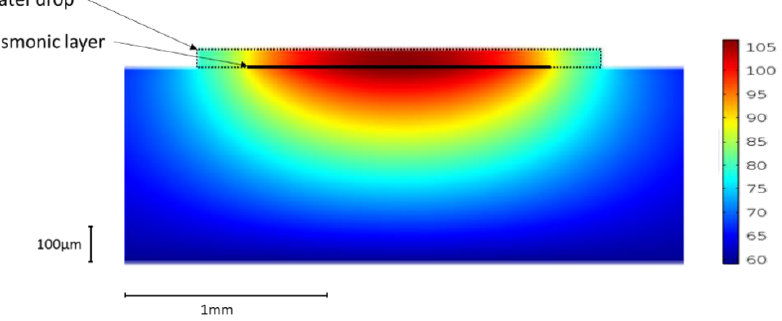
Figure 9. 2D heatmap of the sensor. The injected current is 318 mA. The dotted line symbolizes the water drop contour and the thick line the plasmonic layer. water drop contour and the thick line the plasmonic